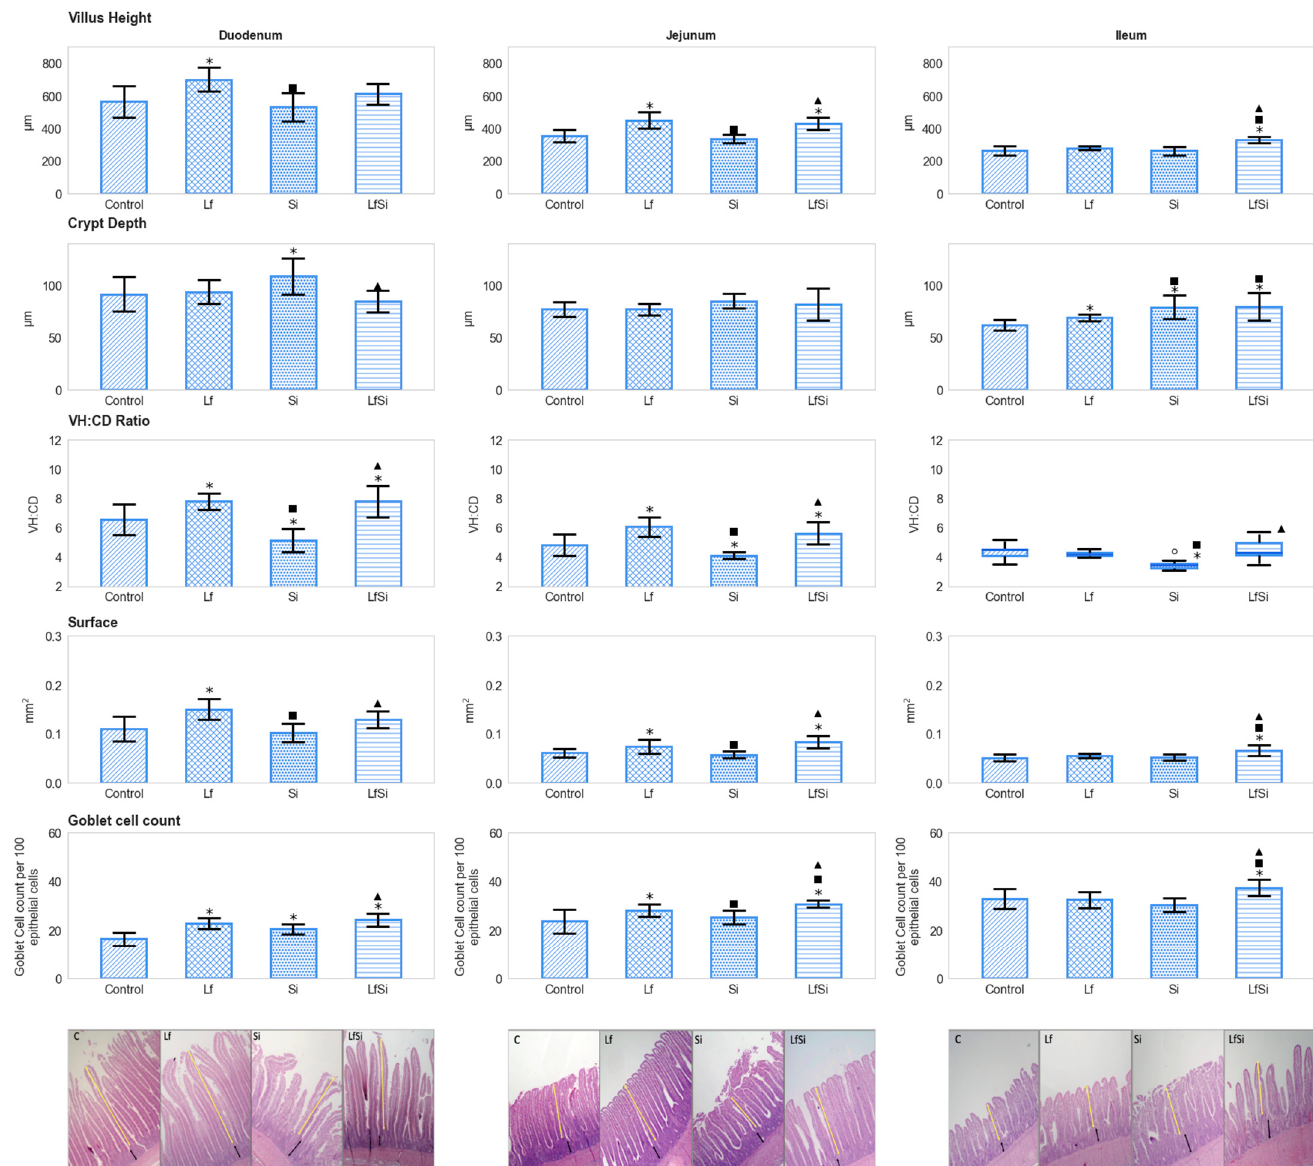
Figure 1. Effects of bacterial administration on morphological characteristics of the small intestine in broiler chickens with respective illustrative photomicrographs (40× magnification, HE staining). Values are means plus SD ( n = 10). Box plots are used for depicting medians with their corresponding interquartile range (IQR). * designates differences from the control group ( p < 0.05), ■ from the Lf group, and ▲ from the Si group. Lf: L. fermentum ; Si: S . Infantis; VH: villus height; CD: crypt depth; SD: standard deviation. Circles denote outliers. Yellow and black double-headed arrows indicate villus height and crypt depth, respectively. Table 1. Expression levels of ileal muc-2 in probiotic and pathogen-treated broiler chickens.